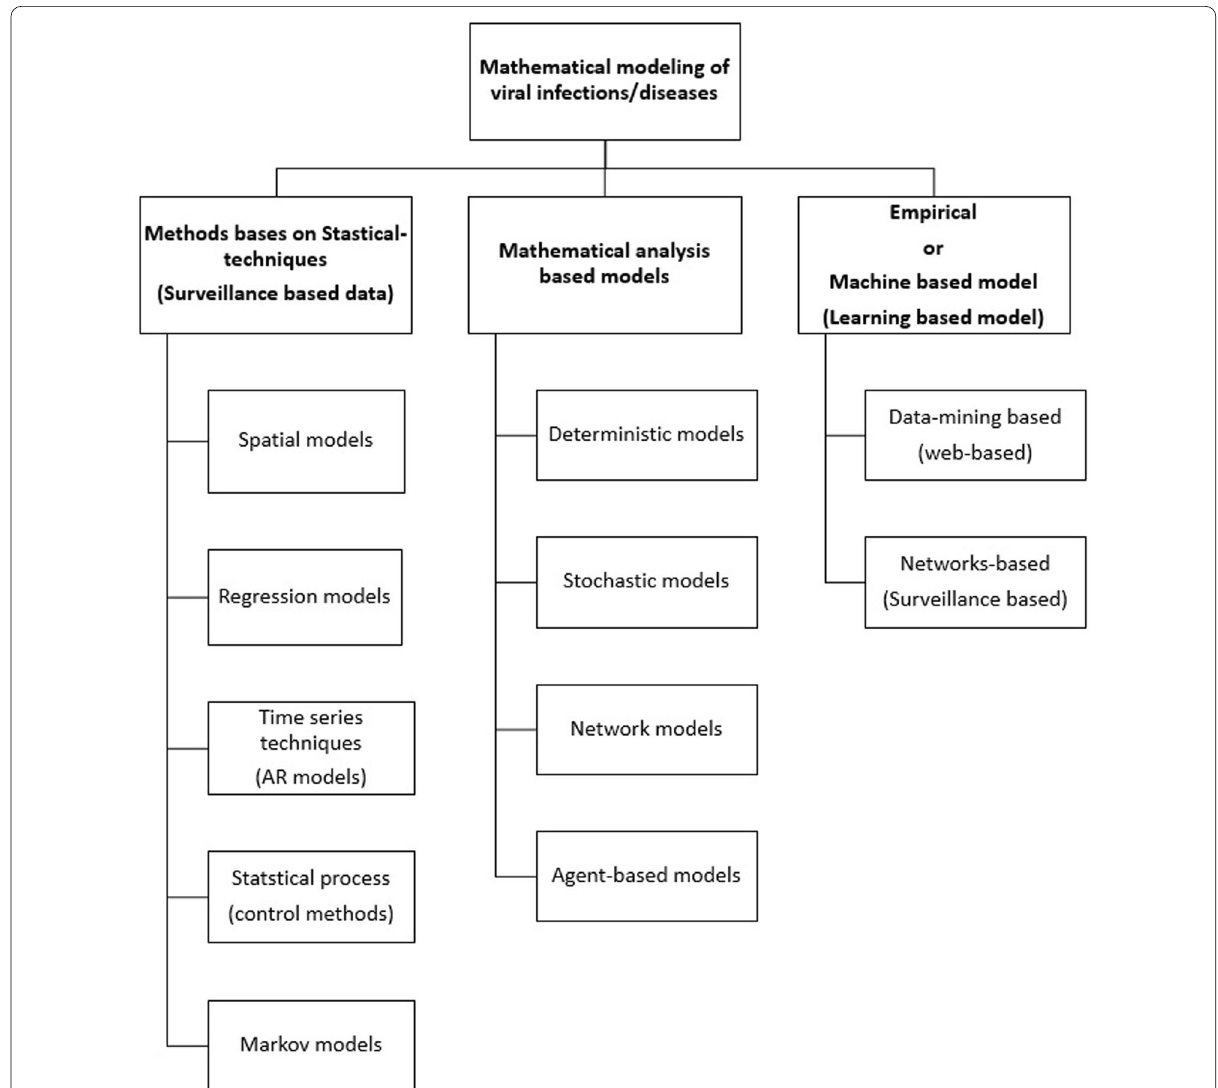
Fig. 8 Different techniques used in mathematical modeling of viral